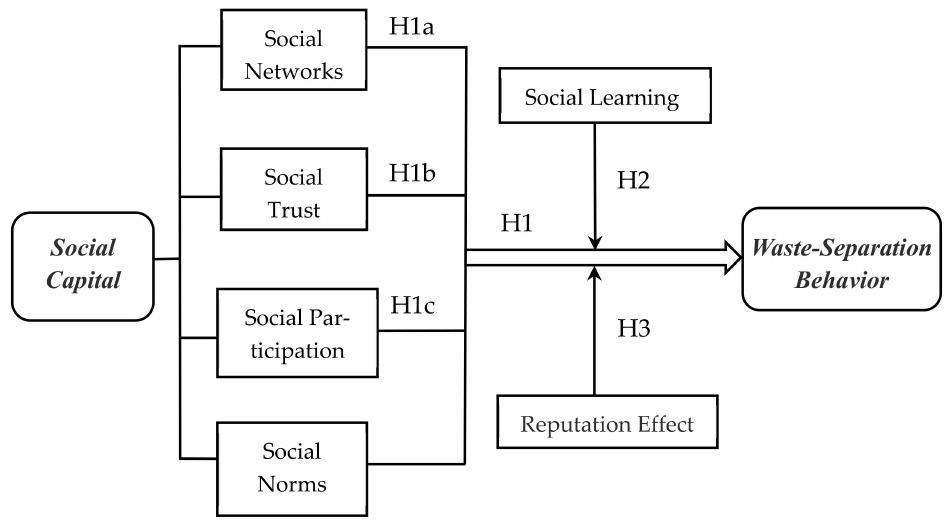
Figure 1. The analytical framework of the social capital impact on waste-separation